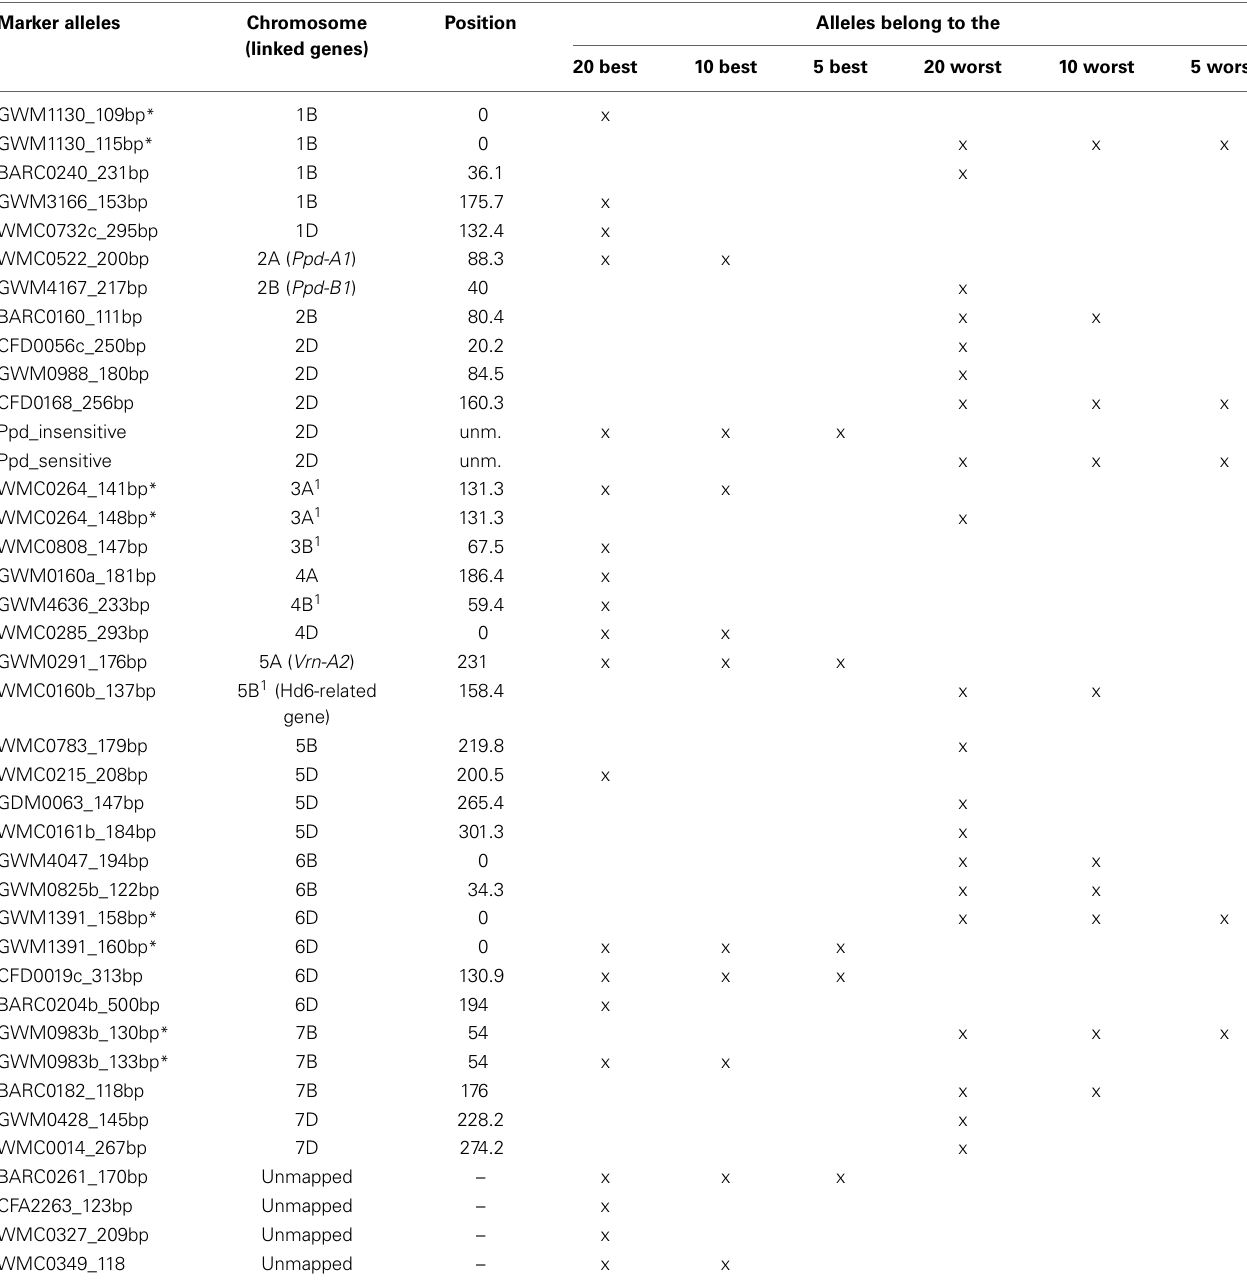
Table 2 | List of the best favorable and worst unfavorable alleles. Marker alleles Chromosome Position Alleles belong to the (linked genes) 20 best 10 best 5 best 20 worst 10